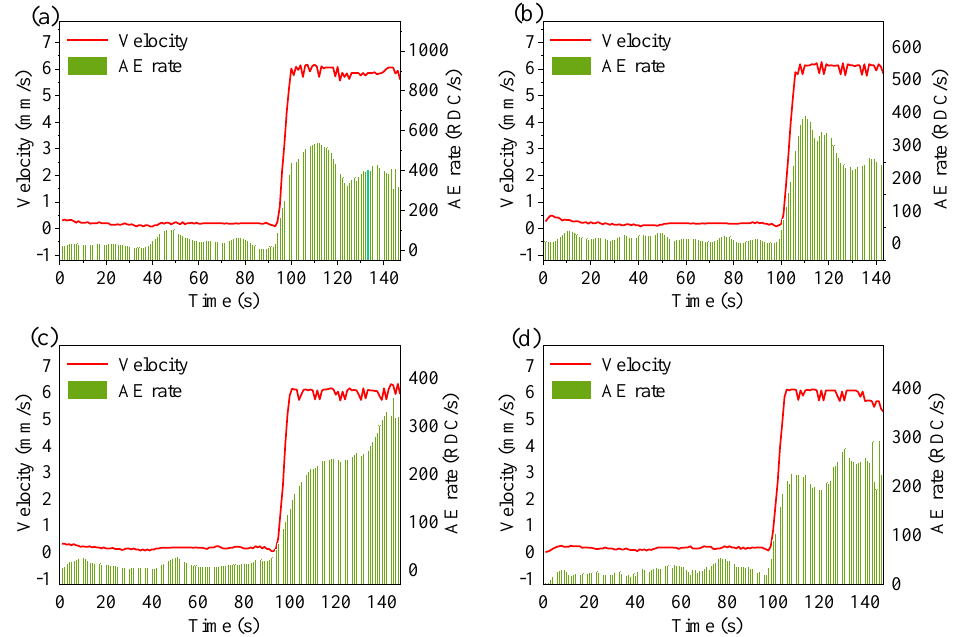
Figure 11. Velocity and ring down count (RDC) plotted against time in ( a ), ( b ), ( c ) and ( d ) for the four experiments. All experimental data points are the moving average value of 5 s.